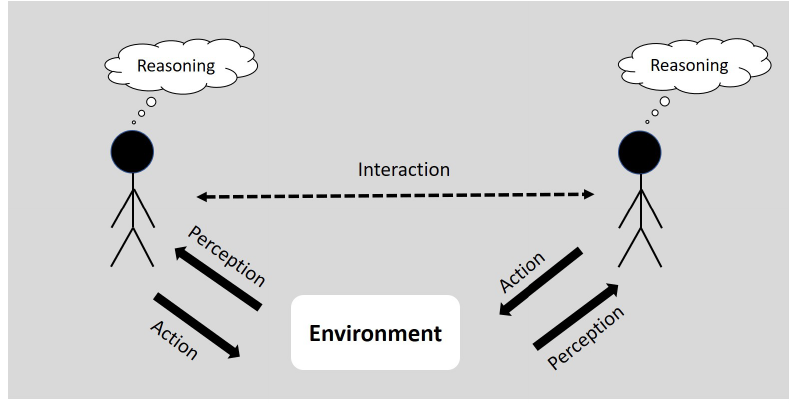
Figure 3. Agent interaction with the